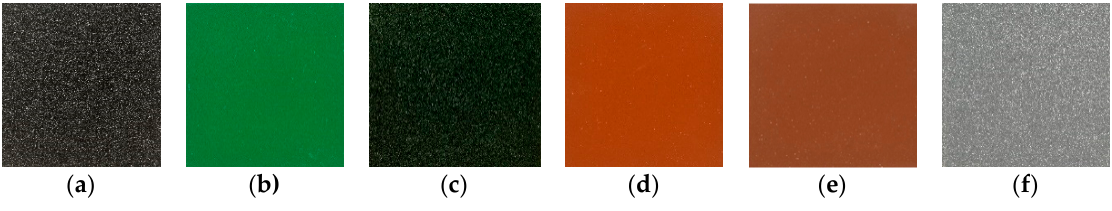
Figure 2. Tested coatings: ( a ) TFI-76521 (perfluoroalkoxy (PFA)); ( b ) TF-531 (fluorinated ethylene propylene (FEP)); ( c ) TFI-851E (polytetrafluoroethylene (PTFE)); ( d ) TS-RTV1 (silicone rubber); ( e ) RTV1 + Ce (silicone rubber +cerium); and ( f ) TFC-51N (sol-gel. Ceramic).